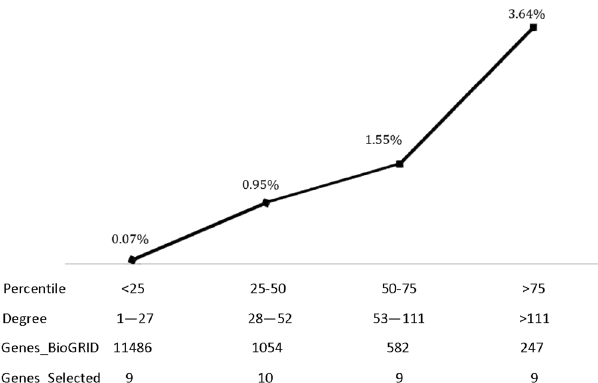
Figure 4. Enrichment of nodes degree in each percentile level for genes in the integrated diagnostic network. The percentile levels were defined as < 25, 25–50, 50–75, and > 75 percentile of the degrees of each gene in the integrated diagnostic network, which correspond to 1–27, 28–52, 53–111, and > 111 number of degrees, respectively. ‘Genes_BioGRID’ represents the number of genes from BioGRID felt into a given percentile level of node degree, and ‘Genes_Selected’ shows that from the integrated diagnostic